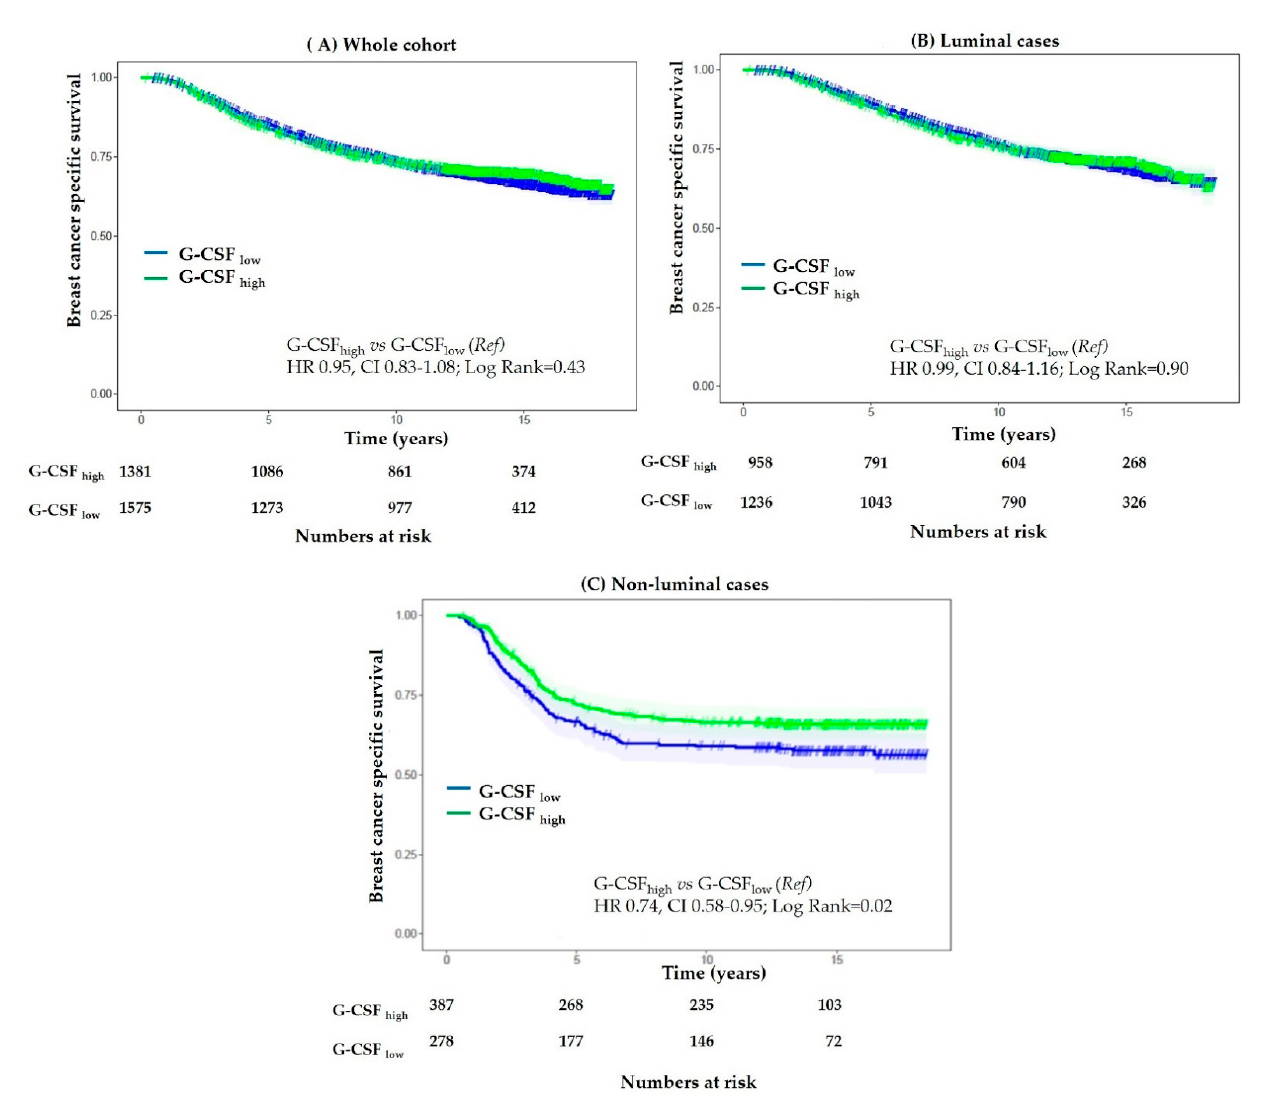
Figure 2. Cohort II: Kaplan–Meier curves: Association of G-CSF expression with breast cancer-specific survival (BCSS). No significant difference in BCSS was observed in the whole cohort ( A ) and cases with luminal subtype ( B ). An improved BCSS was observed in cases with non-luminal subtype ( C ).